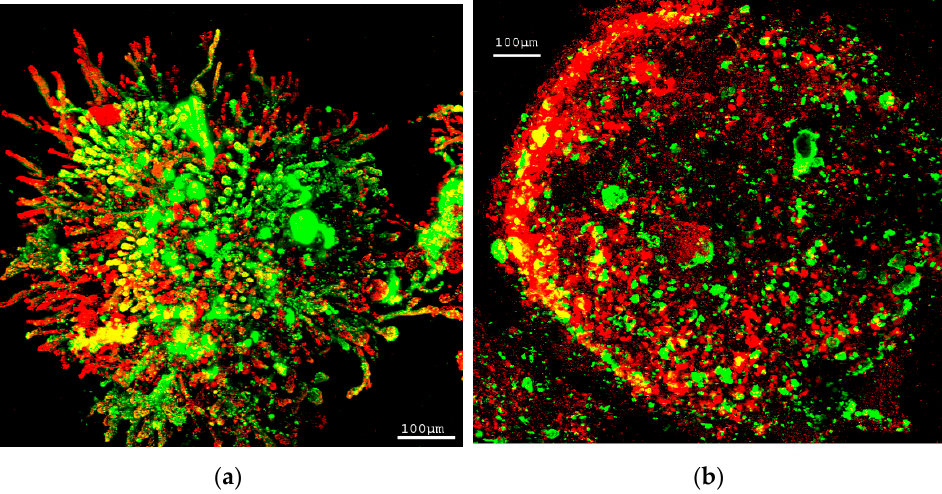
Figure 2. Distribution of bacteria (red) and EPS (green) in small aggregate and granule (diameter < 1 cm). ( a ) A small aggregate; ( b ) a small granule. Scale bar = 100 μ m.